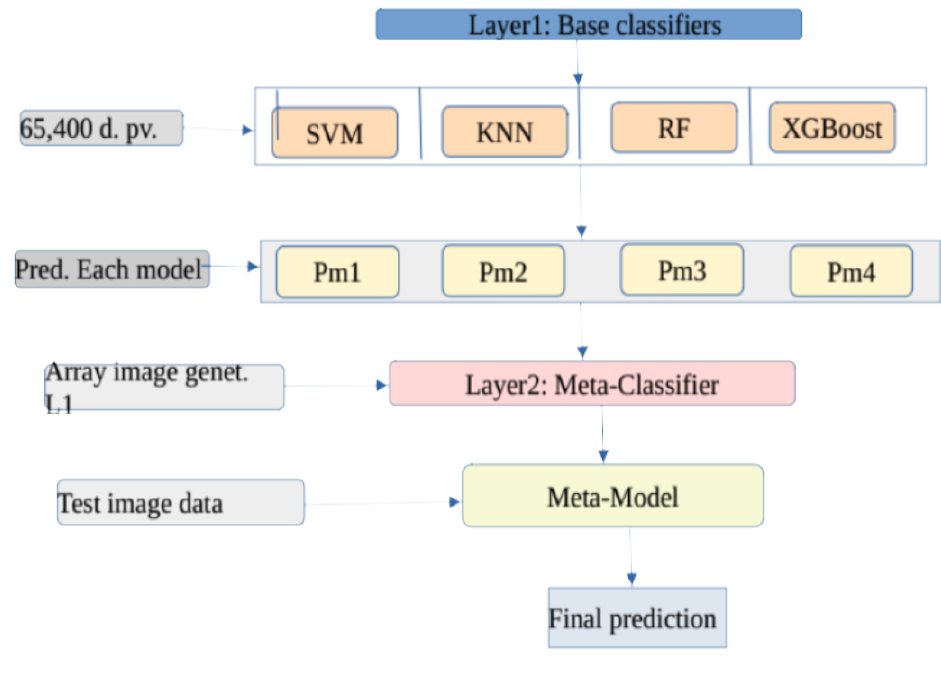
Figure 1. Proposed model